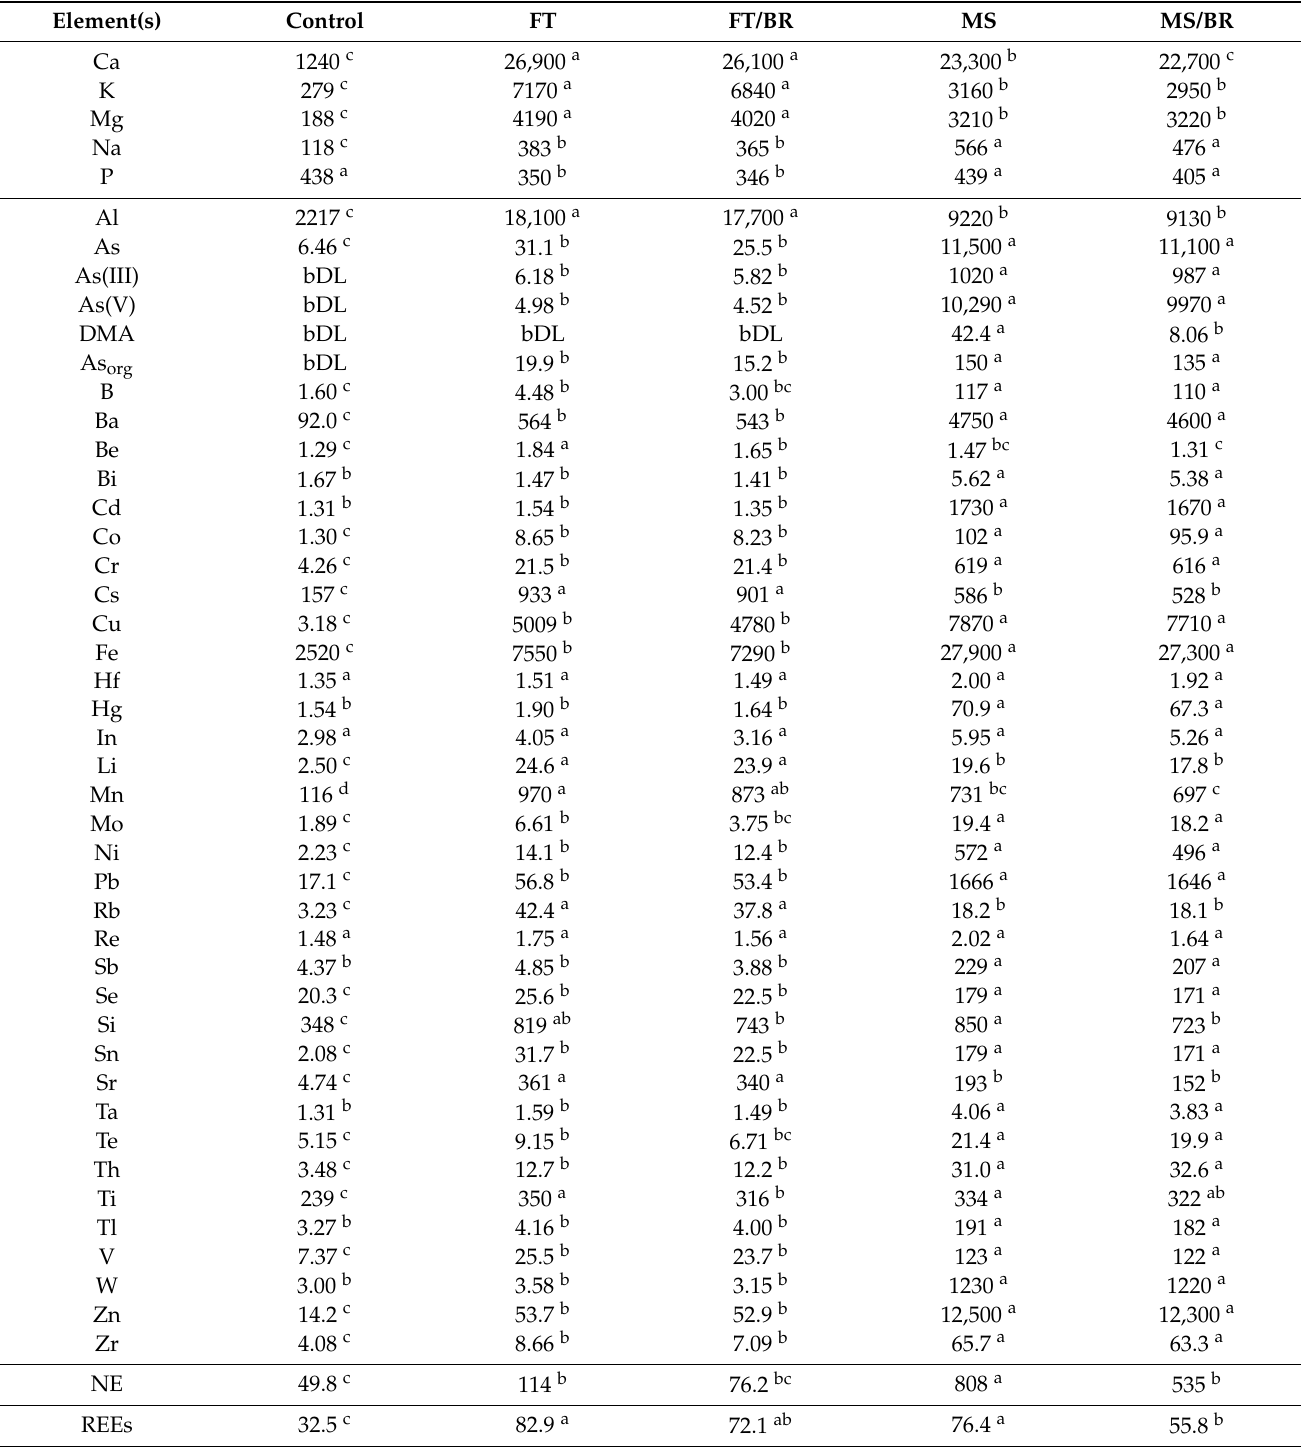
Table 2. Concentration of major and trace elements (mg kg − 1 DW) in substrates used in the experiment ( n = 3).